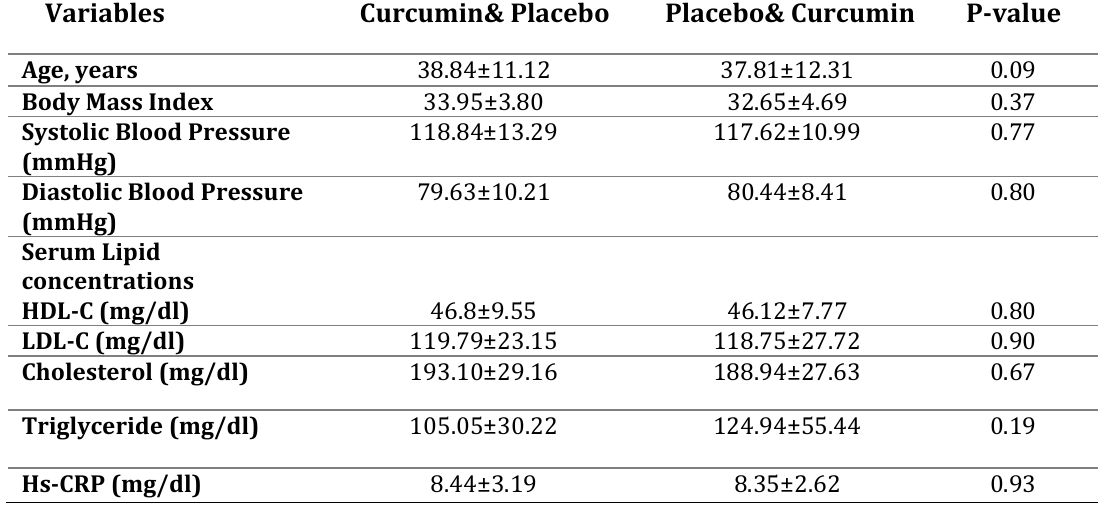
* Mean ± standard deviation for continuous variables